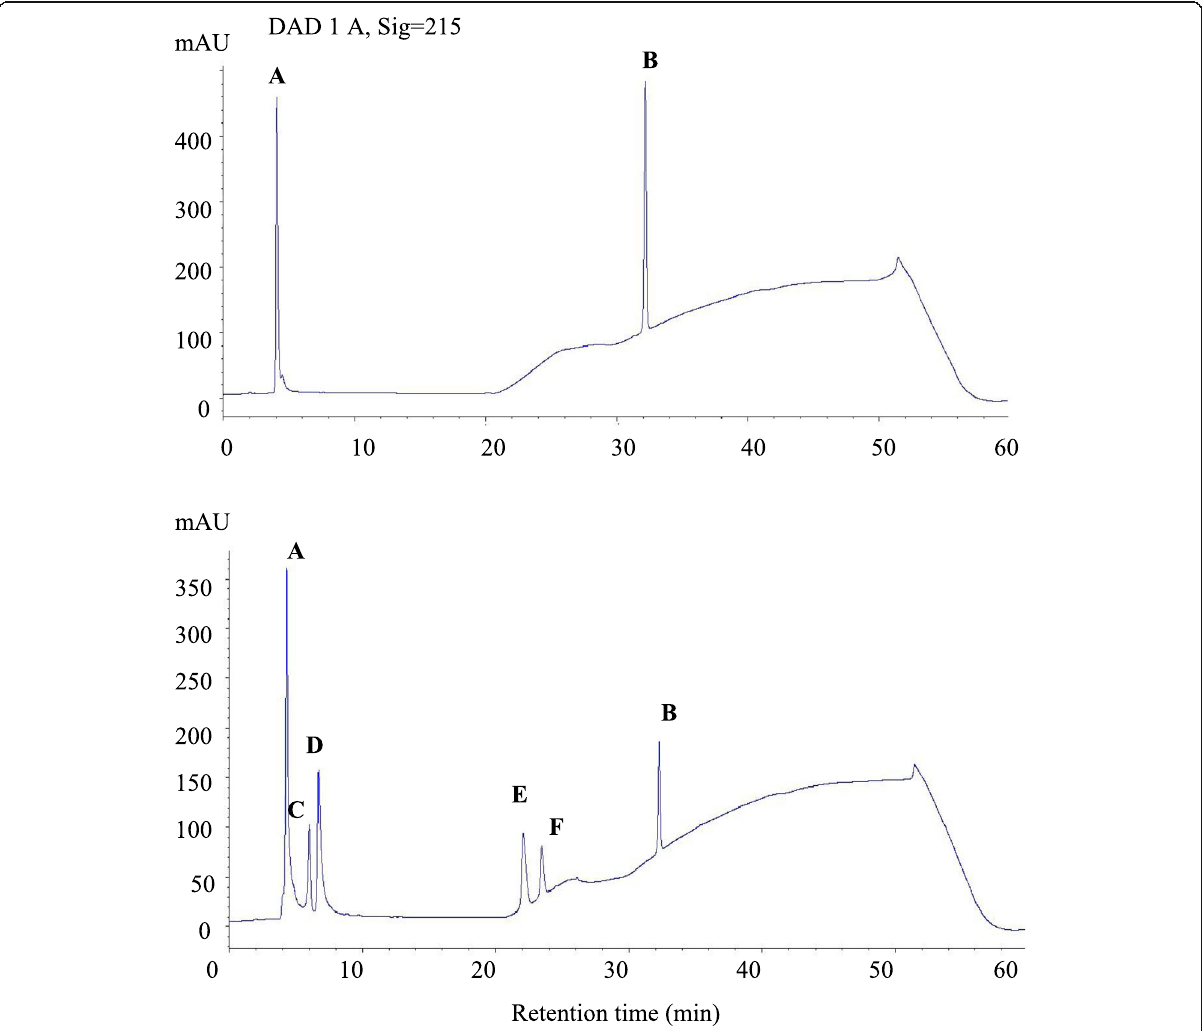
Fig. 1 High-performance liquid chromatography (HPLC) chromatograms of starting materials (top) and resultants (bottom) of acidolysis of p -coumaric acid and triolein at 215nm. A : p -coumaric acid; B : triolein; C : monooleyl p -coumarate; D : oleic acid; E : diolein; and F : dioleyl p